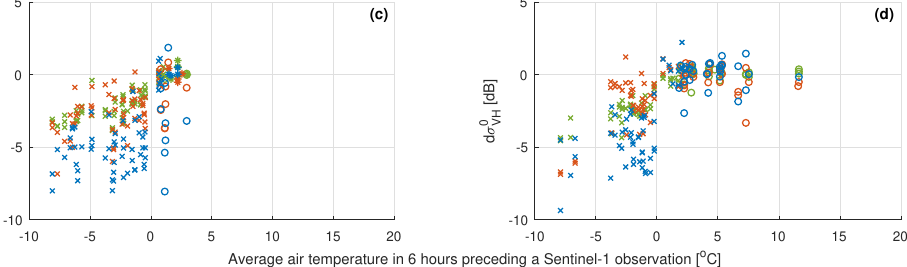
Figure 7. The effect of air temperature on the seasonal anomalies ( d σ 0 ) when snow was present, for the Sentinel-1 VV σ 0 observations acquired in the morning overpasses ( a ) and the evening overpasses ( b ), and the Sentinel-1 VH σ 0 observations acquired in the morning overpasses ( c ) and the evening overpasses ( d ). Each data point represents a single Sentinel-1 observation. The Sentinel-1 observations masked for rain interception are not included, whereas the Sentinel-1 observations that are masked for frozen conditions are included (marked with a